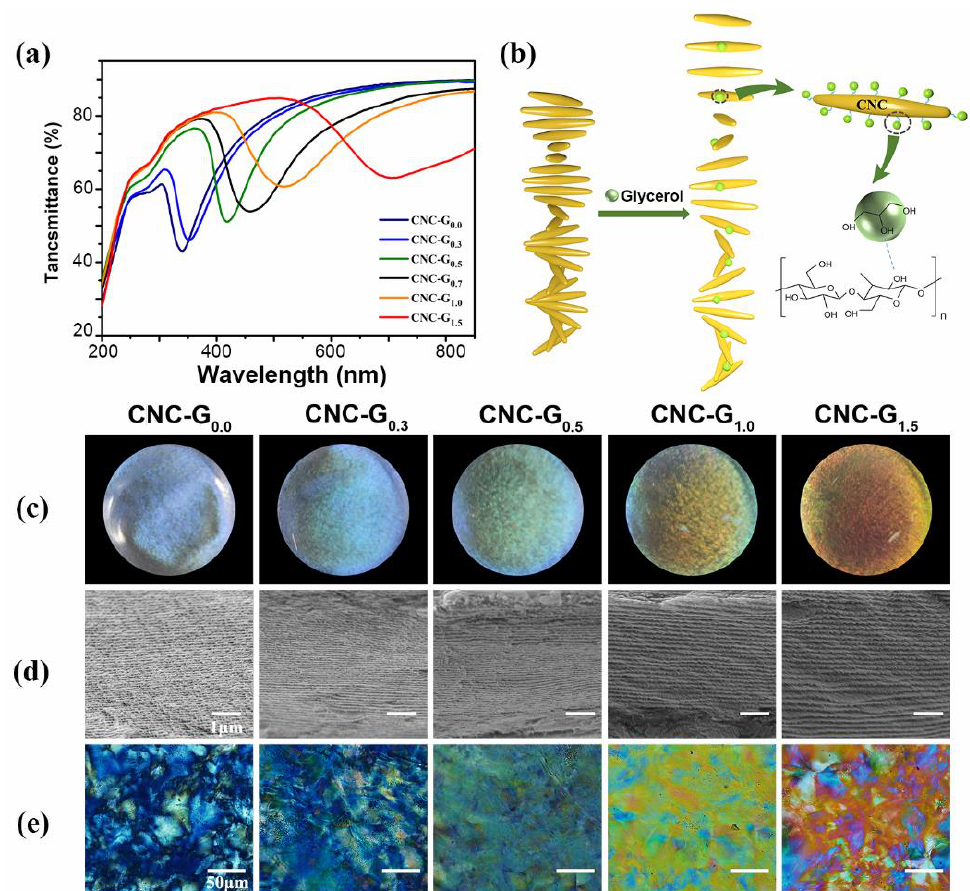
Figure 6. ( a ) Transmission spectra of CNC and CNC-glycerol composite films; ( b ) schematic diagram of CNC-glycerol composite films with a chiral nematic structure; ( c ) photographs of CNC-glycerol composite films. Under natural light (d = 3.5 cm), ( d ) the corresponding cross-sectional SEM images of the CNC-glycerol composite films and ( e ) POM images of the CNC-glycerol composite films. According to the hygroscopic property of glycerol, the stimulation response perfor- mance of CNC-glycerol composite films to hydrochloric acid gas was investigated. Taking CNC-G 0.5 as the representative, it is stored in a closed space filled with hydrochloric acid gas for different periods of time (Figure 7). We can see that with the increase in the place- ment time, the structure color of the composite film CNC-G 0.5 became red. After removing hydrochloric acid gas and drying the CNC-G 0.5 composite film, the composite film can recover from red to its original color. CNC-G 0.5 composite film has a reversible stimulation response to hydrochloric acid gas and can be repeated many times, so the reversibility is good. The red-shifted structural color of CNC-glycerol composite film is mainly because when the composite film is in a space filled with hydrochloric acid gas, the molecules of hydrochloric acid gas can diffuse into the periodic lamellae of CNC-glycerol composite film, resulting in the expansion of the spiral lamellae and an increase in the pitch, which makes the reflection wavelength and structural color red-shift. When the hydrochloric acid is removed, the hydrochloric acid gas molecules entering the composite film diffuse out, causing the pitch of the film to decrease and the reflection wavelength and structure color to